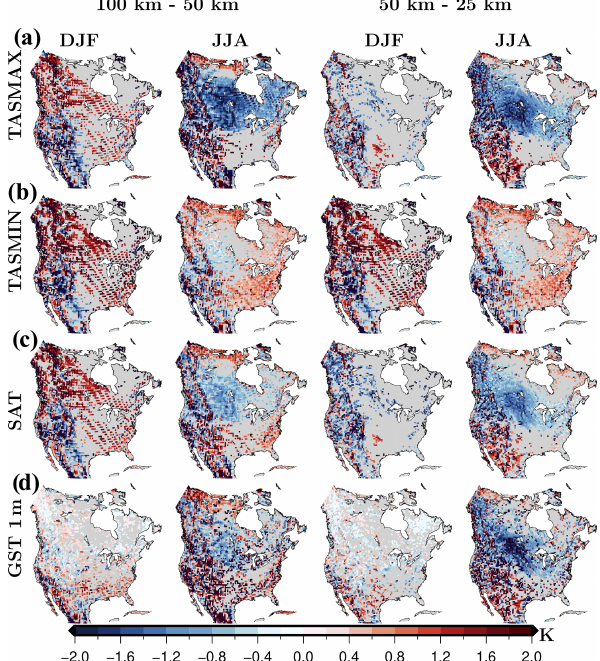
Figure 7. Seasonal mean difference in near-surface temperature conditions between the 100 and 50km simulations (left) and be- tween the 50 and 25km simulations (right). All outputs are from the NOAH-MP-DV simulations for the period 1980–2013. Grid cells with a non-significant change at the 5% significance level are masked in grey. All outputs from the 25, 50 and 100km simulations were mapped to a common grid (CRU grid) using the nearest model grid